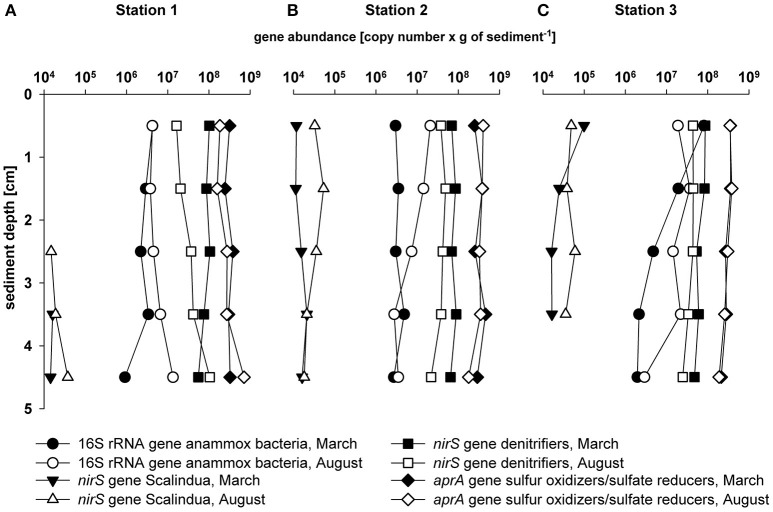
Depth profiles of anammox bacteria 16S rRNA gene abundance [copies g−1] (circle); anammox bacteria nirS gene abundance [copies g−1] (triangle), denitrifying bacteria nirS gene abundance [copies g−1] (square); SOB and SRB aprA gene abundance [copies g−1] (diamond); (A) Station 1; (B) Station 2; (C) Station 3; black symbol: March; white/gray symbol: August.